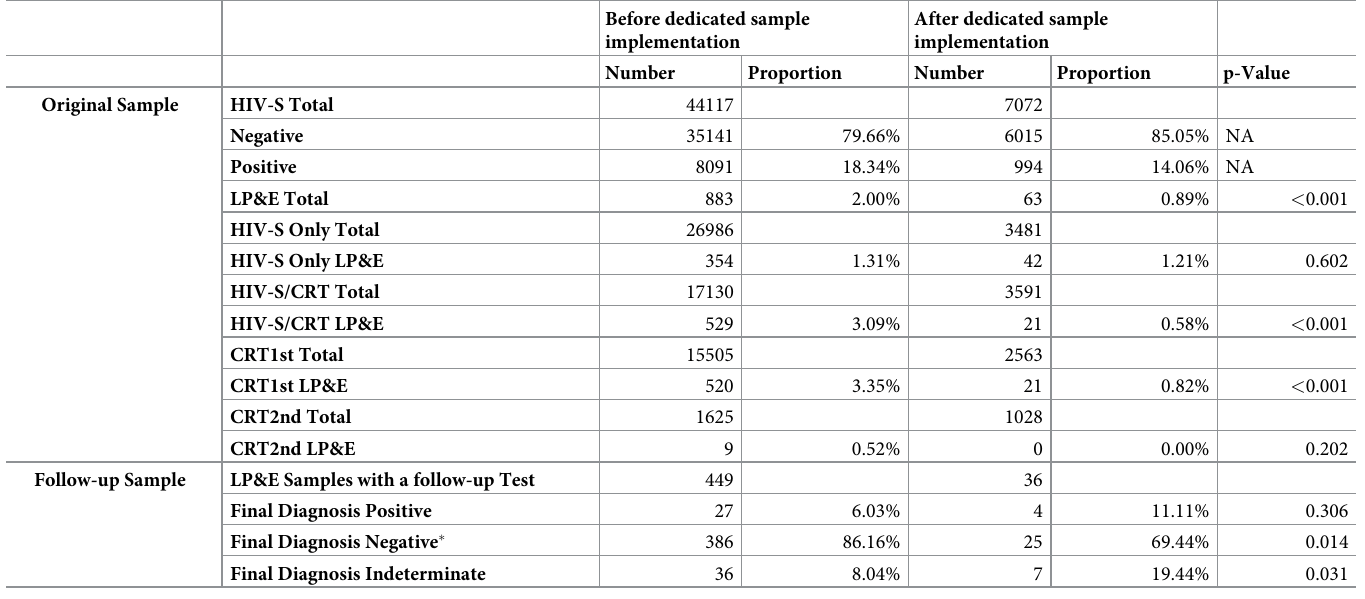
Table 1. Summary of Low Positive and Equivocal (LP&E) HIV antibody rates in samples tested before and after introduction of a dedicated sample tube for HIV serology.